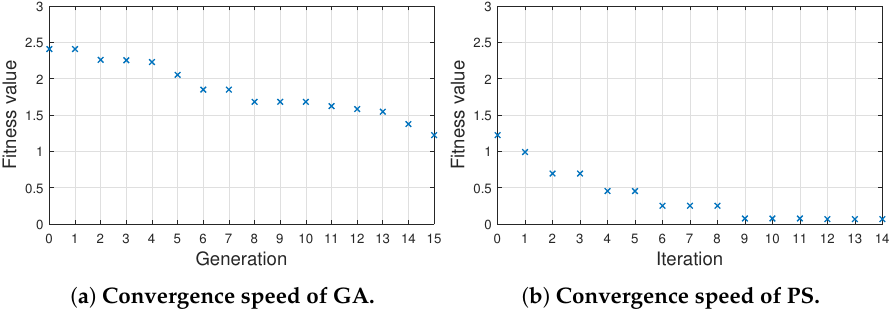
( b ) Convergence speed of PS.